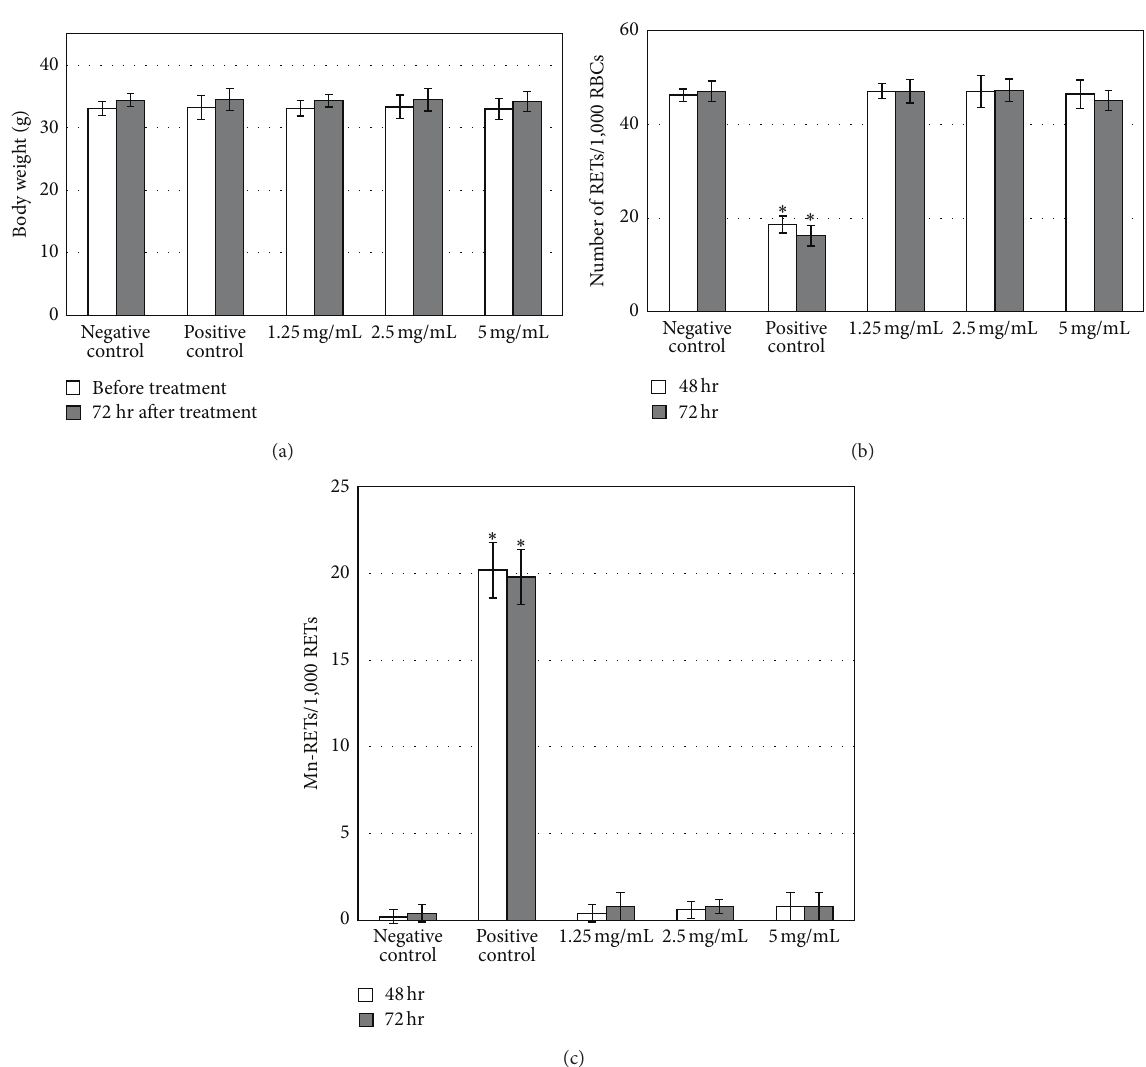
Figure 3: The multispecies probiotic mixture does not induce increased number of micronucleated reticulocytes in mouse peripheral blood. (a) Body weight of mice before and 72 hours after ingestion of the test substance. (b) The number of reticulocytes in 1000 red blood cells from the peripheral blood of mice treated with control and test substance. (c) The number of micronucleated reticulocytes in 1000 reticulocytes. All graphs present mean ± SD ( 𝑛 = 5 ). RETs: reticulocytes; RBCs: red blood cells; Mn-RETs: micronucleated